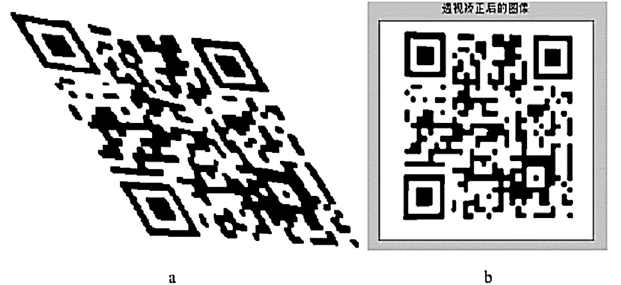
Figure 12: The image after perspective correction.